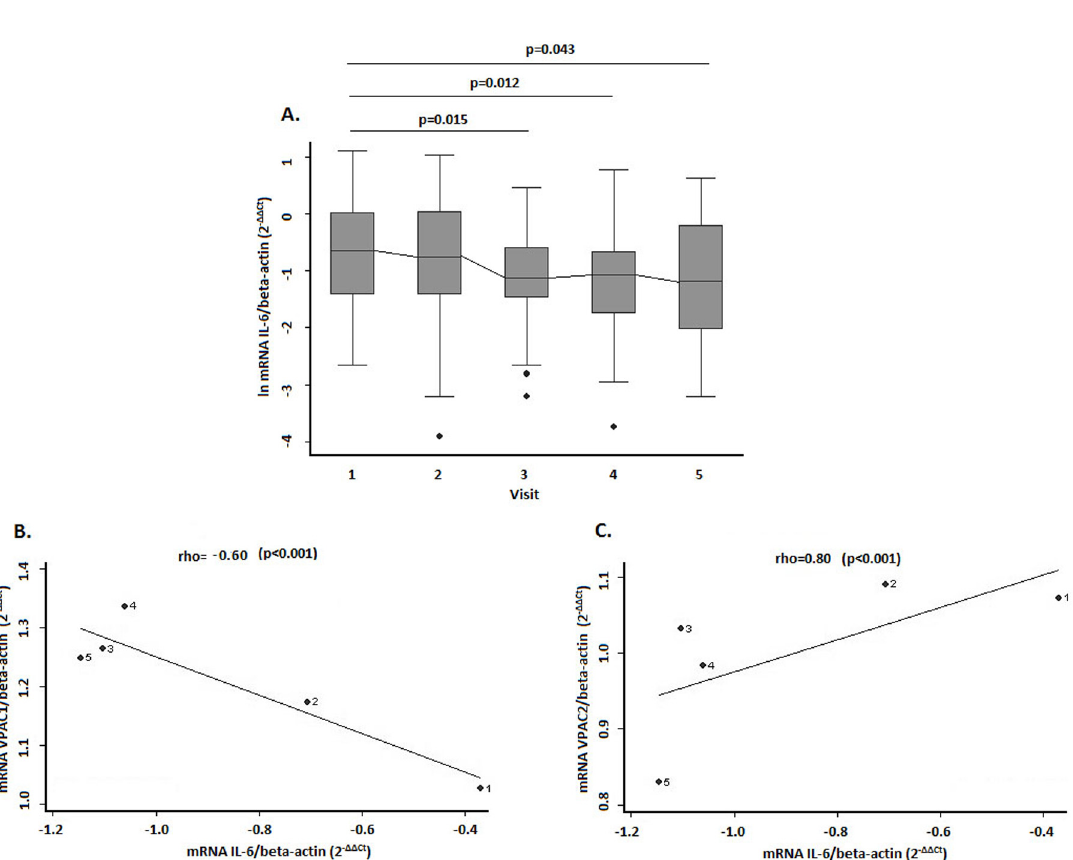
Fig 3. Correlation between gene expression levels of VPACs receptors and IL-6 in PBMCs from EA patients. (A) Evolution of IL-6 expression in the EA cohort during the follow-up. Data are represented as the interquartile range (p75 upper edge of the box, p25 lower edge, p50 midline), p90 (line above the box), and p10 (line below the box) of the expression of IL-6. Dots represent outliers. (B) and (C) Correlation between gene expression of VPAC1 and IL-6 (panel B) and between VPAC2 and IL-6 (panel C). Statistical significance was established using the Trend test and non-parametric posteriori test (Dunnett) for intergroup comparison, in panel A. In panels B and C the significance level was obtained by means of a generalized linear model nested by patient and visit. In panels B and C dots represent data from patients clustered by visits from 1 to 5.